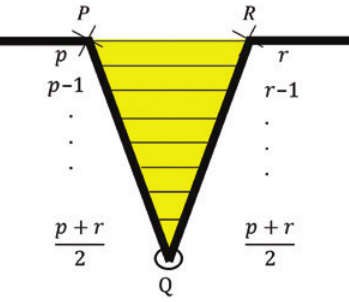
Figure 6: Delineation of Sunken Boundary